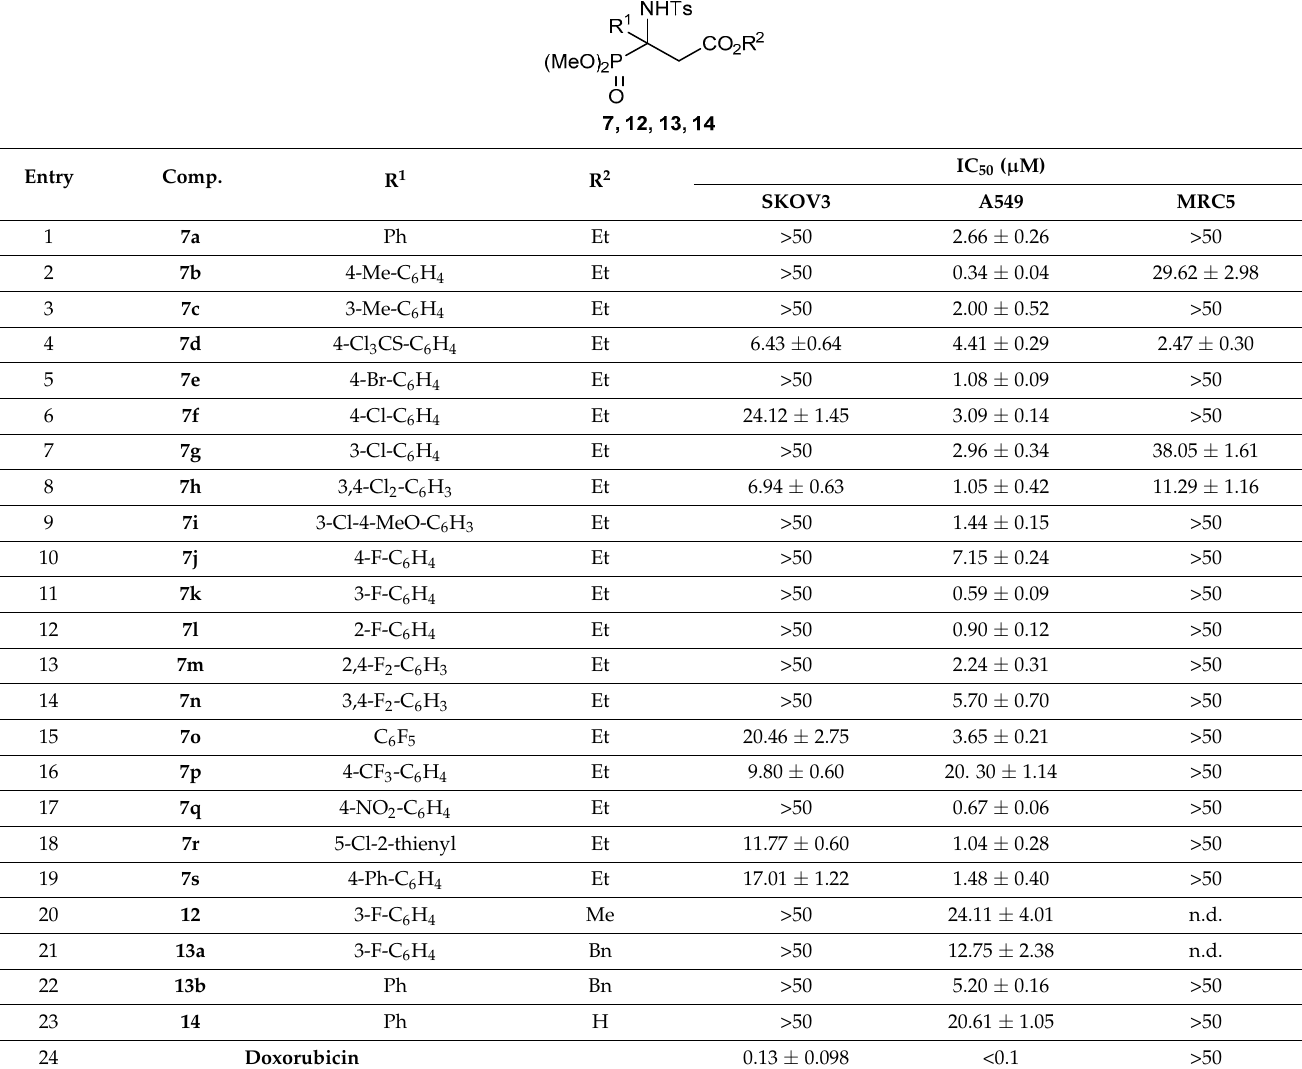
Table 2. Antiproliferative activity of phosphorated analogs of aspartic acid 7, 12–14 against lung and ovarian cancer cell lines.